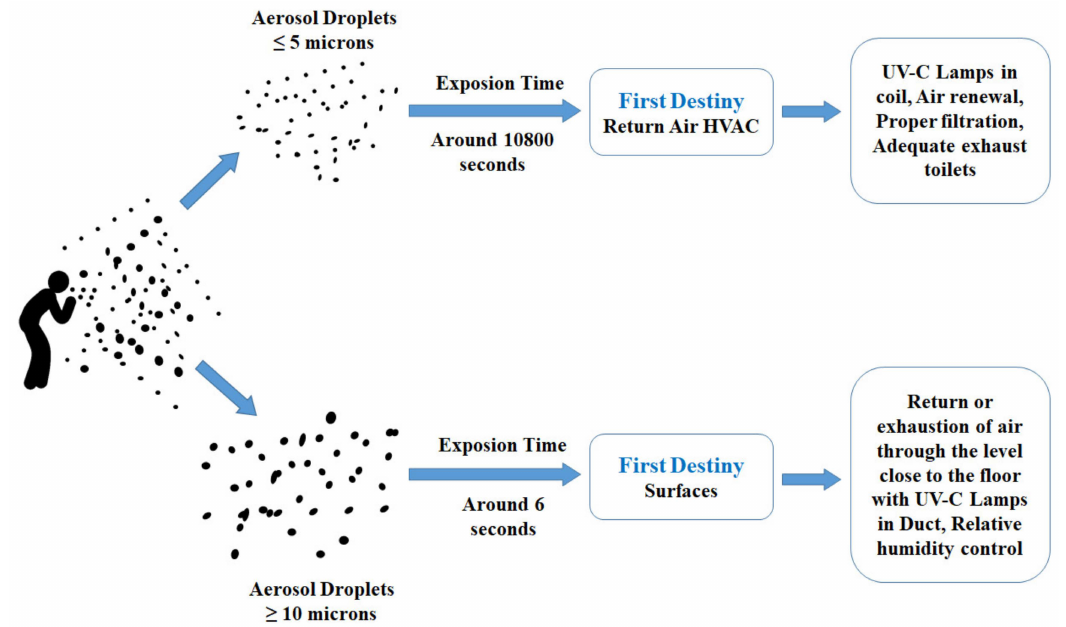
Figure 6. Contagion sources vs. strategies to prevent contagion. Reproduced with permission from [87].